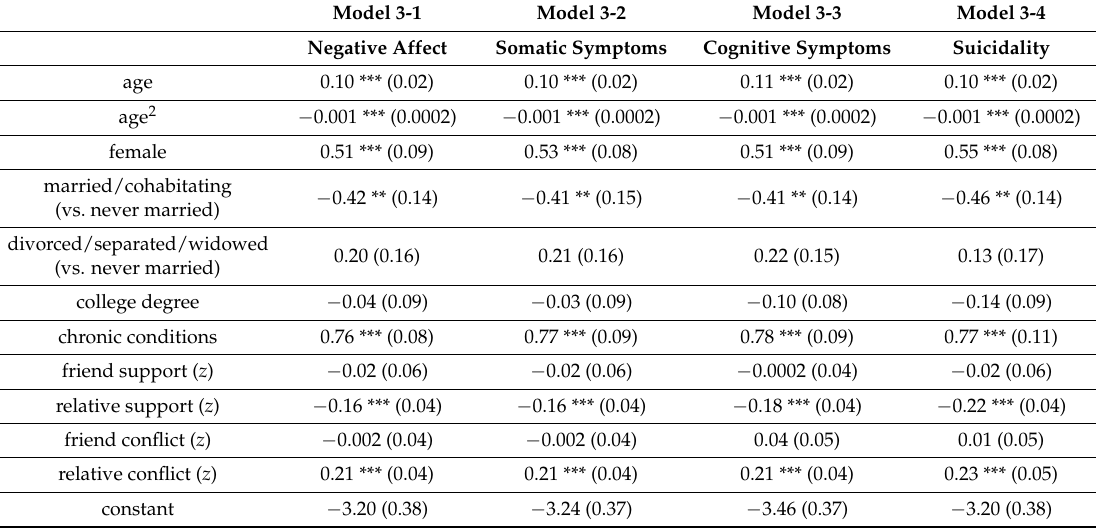
Table 8. Weighted Logistic Regression on Four Dimensions of Depression among Non-Hispanic